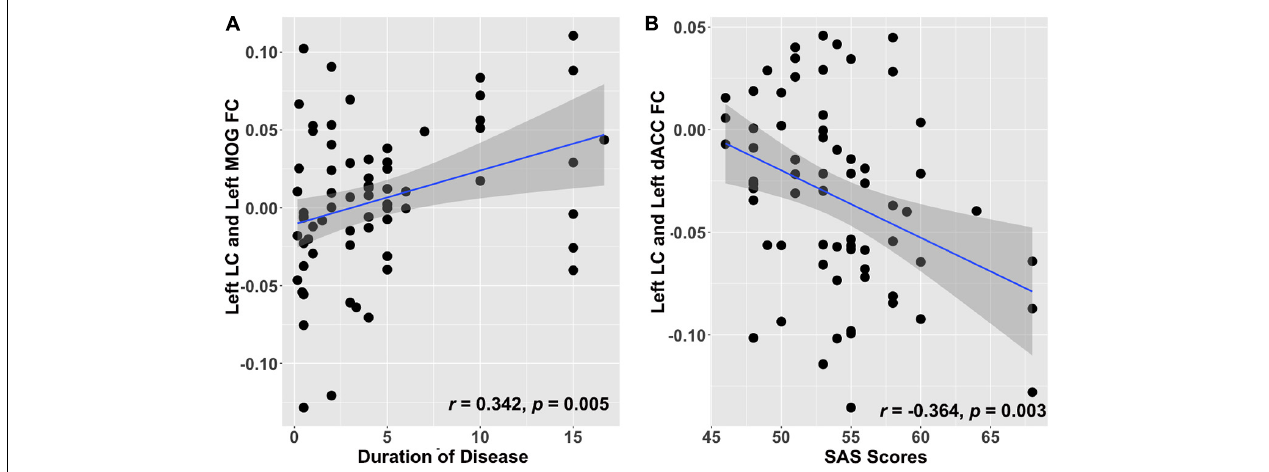
FIGURE 3 | Clinical significance of altered LC-NE functional network in patients with CID. (A) Increased LC-NE FC in left MOG is positively associated with duration of insomnia. (B) Decreased LC-NE FC in the left dACC is negatively associated with anxiety symptom in patients with CID. LC-NE, locus coeruleus-norepinephrine; CID, chronic insomnia disorder; MOG, middle occipital gyrus; dACC, dorsal anterior cingulate cortex.